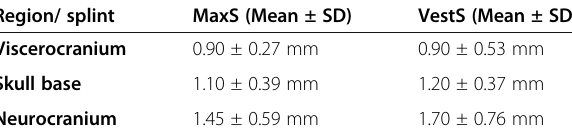
Accuracy of maxillary (MaxS) and vestibular splints (VestS) for the region: viscerocranium, skull base, and neurocranium in mm (mean ± standard deviation (SD)). MaxS: chairside fabricated Maxillary splint, fixed on dentate maxilla VestS: chairside fabricated Vestibular splint (pacifier), fixed as intermaxillary pacifier